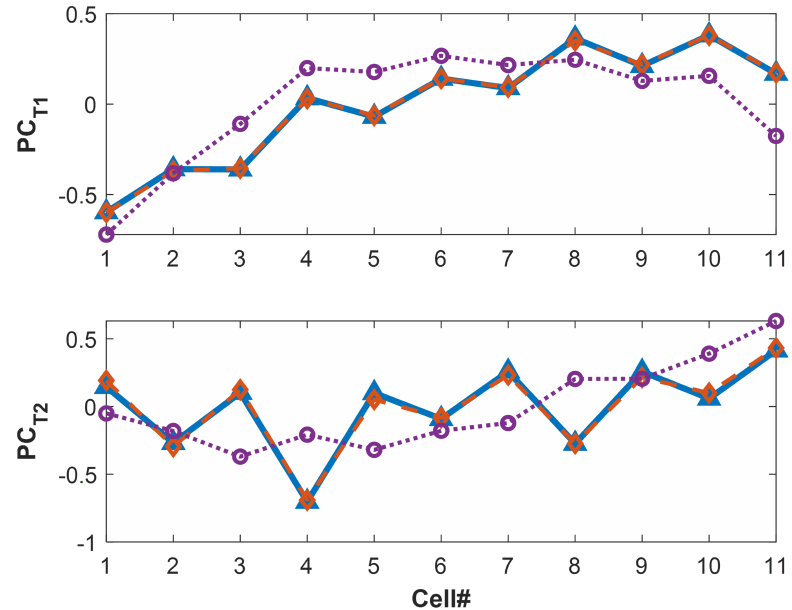
Figure 13. First two temperature principal components before balancing (cid:52) (solid), during balancing (cid:13) (dotted), and after balancing ♦